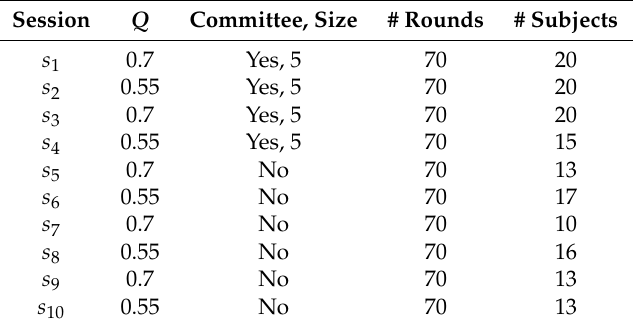
Table 1. Summary of experimental sessions. The accuracy of the private signal was set to q = 0.6 throughout the whole experiment. A total of 75 subjects were assigned to a “group” condition, and divided in committees of size five. The other 82 subjects were assigned to an “individual” condition. Session Q Committee, Size # Rounds #